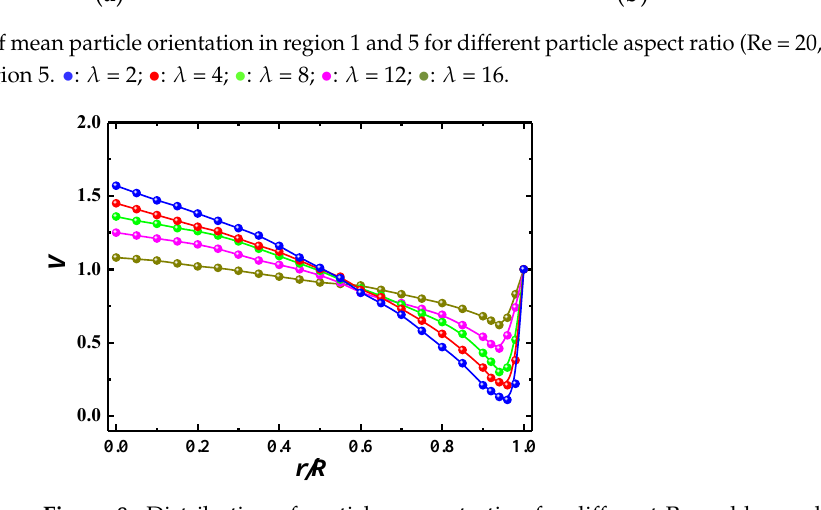
( b ) Figure 9. Distribution of mean particle orientation in region 1 and 5 for different Reynolds numbers ( λ = 8, L/D = 200). ( a ) Region 1 and ( b ) region 5. ●: Re = 5000; ●: Re = 10,000; ●: Re = 20,000; ●: Re = 30,000; ●: Re = 40,000. 5.3. Penetration Efficiency The penetration efficiency is inversely proportional to the particle deposition veloc- ity. In normal circumstances, the particle deposition velocity is mainly affected by the gravitational force, inertial force of particle, Brownian diffusion, turbulent diffusion and particle shape. In this paper, the gravitational force, and nanoparticles’ inertial forces were negligible. The particles follow the fluid motion, which includes the mean motion and turbulence fluctuation, and the particles near the wall deposit on the wall due to Brownian diffusion and turbulent diffusion, resulting in the reduction of particle penetration effi- ciency. Therefore, the effects of Brownian diffusion, turbulent diffusion and particle shape on the deposition velocity and penetration efficiency should be explored. For the cylindri- cal nanoparticles, the shape was reflected by the aspect ratio.